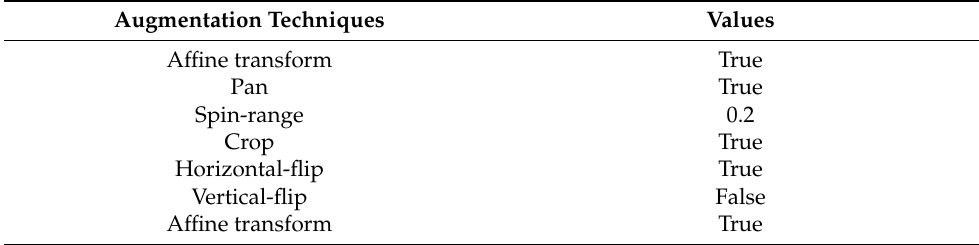
Table 3. Details of utilized data augmentation using image